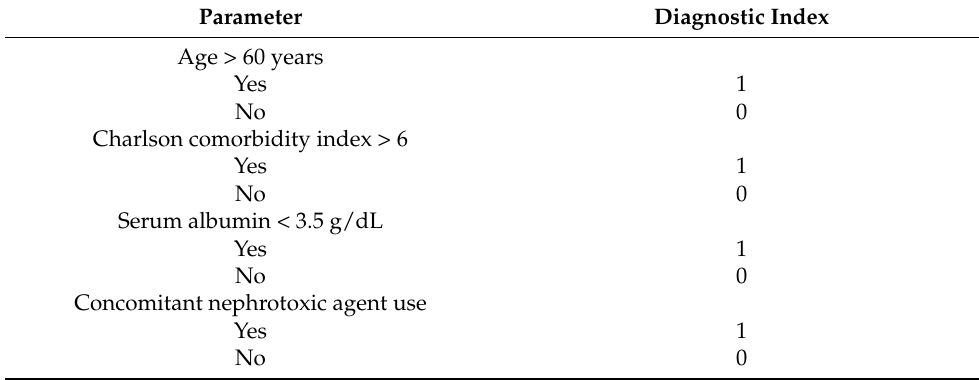
Table 5. Indices of diagnostic scoring system for prediction of nephrotoxicity among the patients receiving intravenous